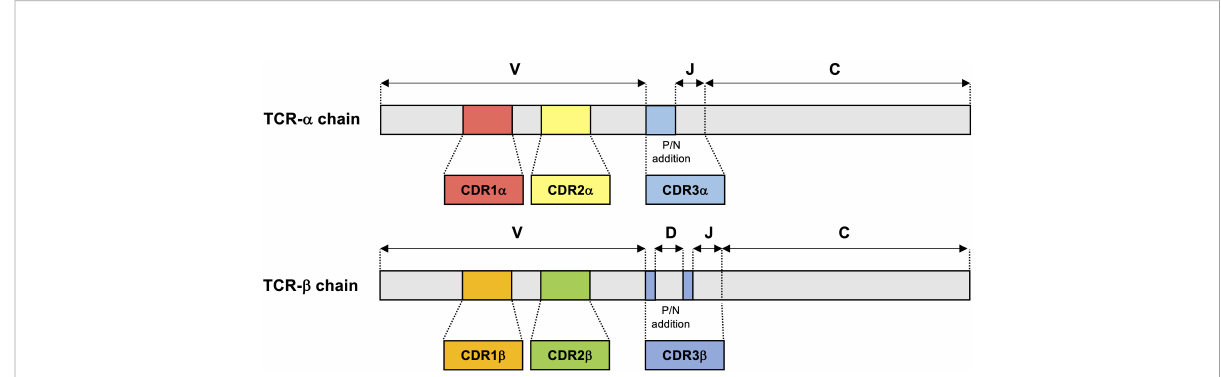
FIGURE 1 TCR- a and TCR- b chain gene structure. TCR- a and TCR- b chains consist of a variable (V) amino-terminal region and a constant (C) region. The complementarity-determining region 1 (CDR1) and CDR2 encoded in the TCR germline V genes, which are conserved across TCR- a and TCR- b . In contrast with CDR1 and CDR2, CDR3 is located at the junction between the rearranged V and joining (J) segments in TCR- a chain and V, diversity (D) and J segments in TCR- b chain. Additions of P- and N-nucleotides (P/N addition) are present in the junctions between the V, D, and J gene segments of the rearranged TCR- b chain and also between the V and J gene segments of all rearranged TCR- a